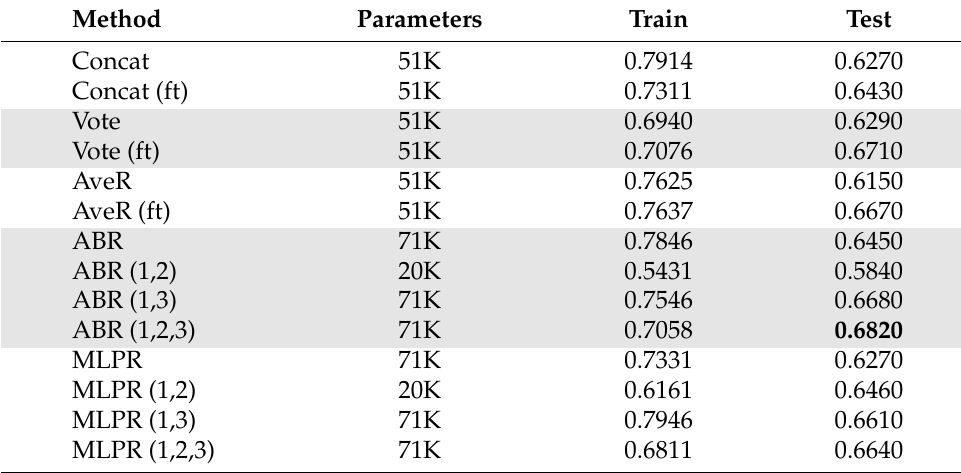
Table 2. Train/test accuracies on the MPE data set and number of parameters for each approach based on